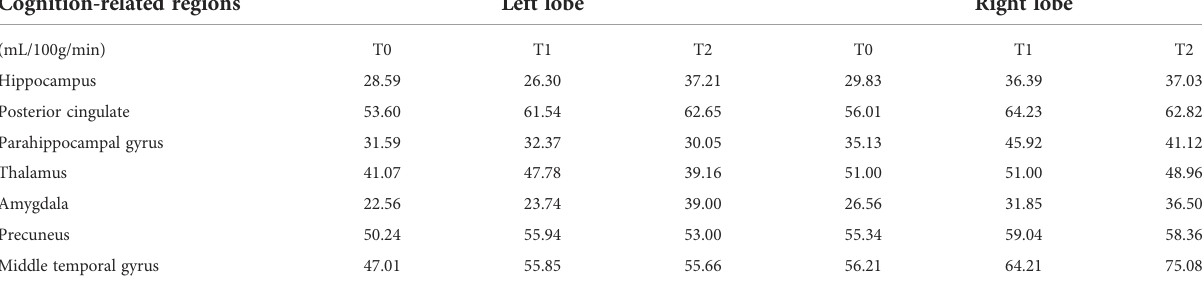
TABLE 2 Cerebral blood fl ow follow-up. Cognition-related